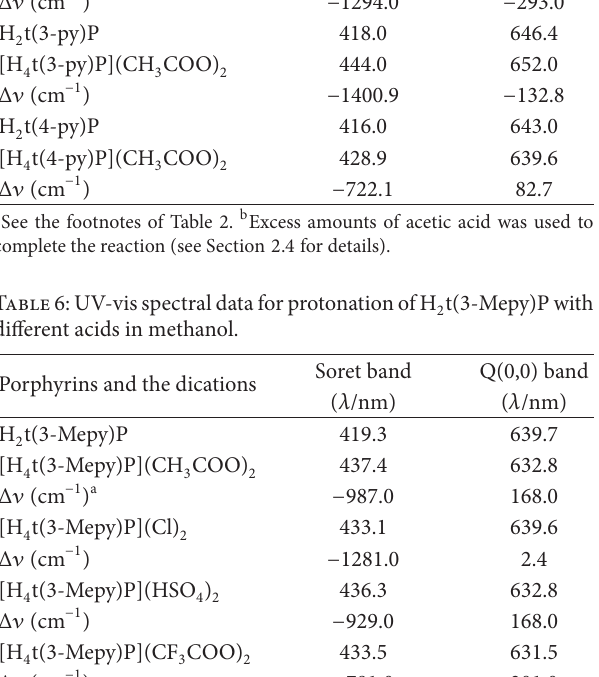
T 5: UV-vis spectral data for interaction of H COOH in CH CH 3 Porphyrins and the dications